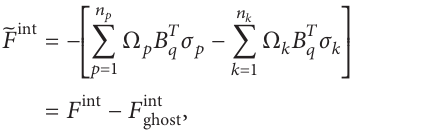
Figure 4. The material parameters are listed in Table 1. As for Young’s modulus E and Poisson’s ratio ] , the pa- rameters are generic and suitable for usual concrete